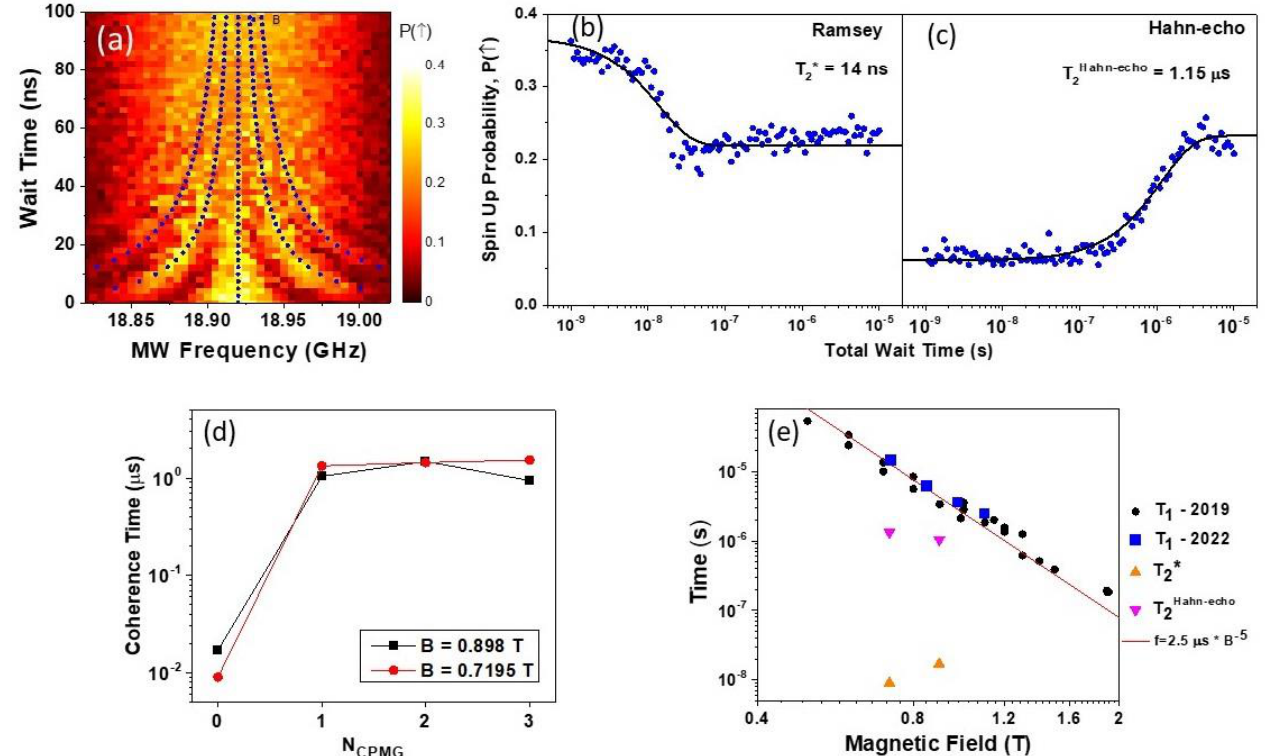
Figure 4. ( a ) Ramsey fringes measured by the spin-up probability using a sequence of two π pulses of different frequencies (X-axis) separated by the wait time (Y-axis). Dotted lines indicate the expected position of the fringes (for more details see text); ( b ) Spin-up probability measured in the Ramsey experiment (points) fitted by an exponential decay (solid line); ( c ) spin up probability measured in Hahn echo experiment (points) fitted with an exponential step function (solid line); ( d ) coherence time for different number of refocusing CPMG pulses for two values of magnetic field (for details see text); ( e ) longitudinal spin relaxation time 𝑇 1 combined with Ramsey and Hahn echo results.